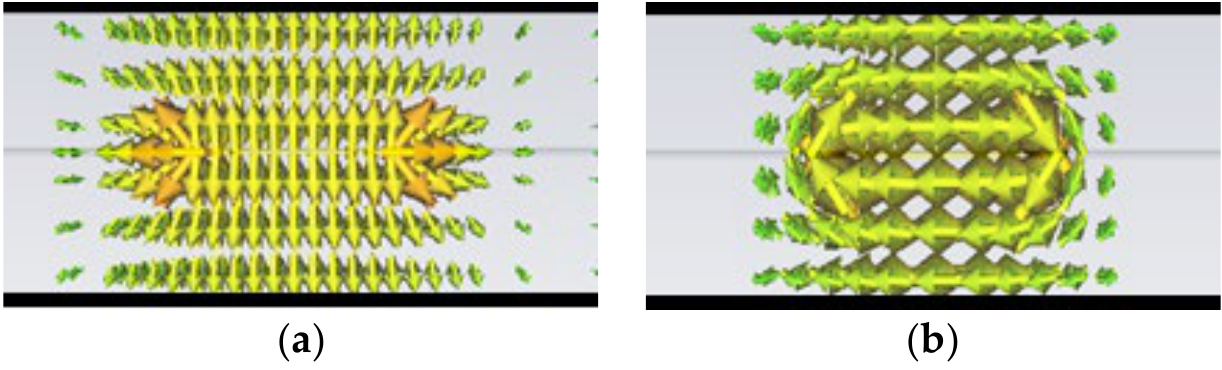
Figure 1. Representation of the EM field distribution in the stripline. ( a ) E-field. ( b ) H-field.